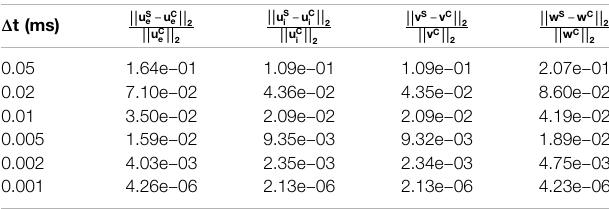
TABLE 4 | Difference between the solution of the coupled approach ( u C i , u C e , v C , w C ) with Δ t (cid:2) 0 . 001 ms and the solution of the splitting approach ( u S i , u S e , v S , w S ) for a number of different values of Δ t , using fi ve inner and outer iterations ( N (cid:2) M (cid:2) 5 ) it it